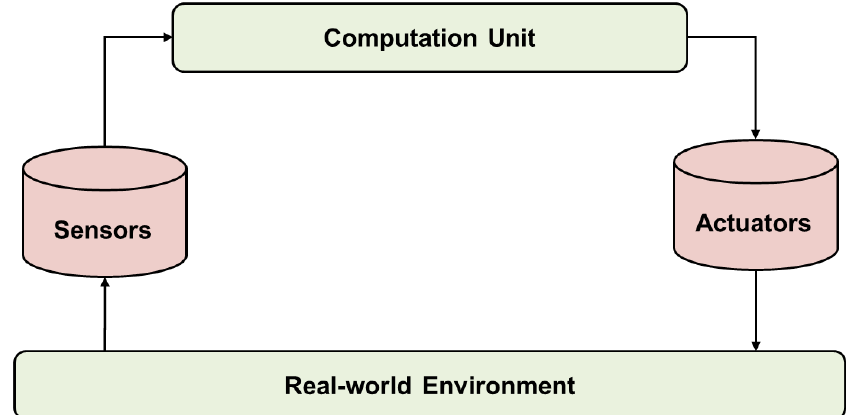
Figure 3. Components of the cyber-physical system.